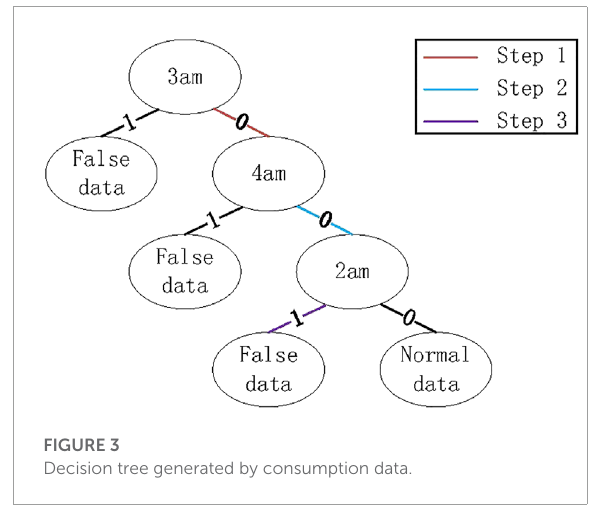
FIGURE 2 False data vs. normal data.